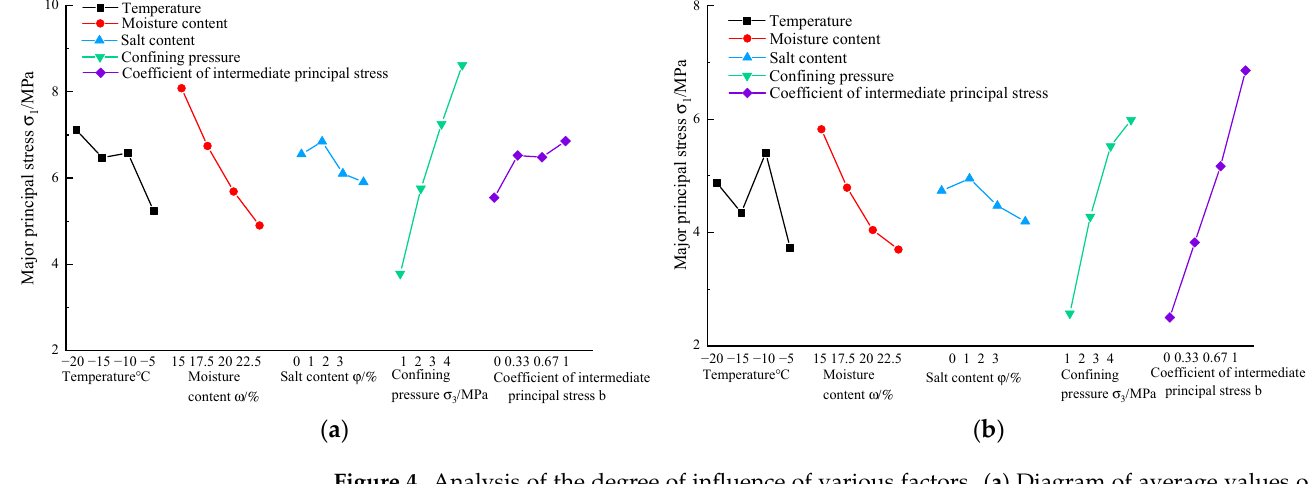
Figure 4. Analysis of the degree of influence of various factors. ( a ) Diagram of average values of factors influencing the major principal stress σ 1 ; ( b ) Diagram of average values of factors influencing the intermediate principal stress σ 2.